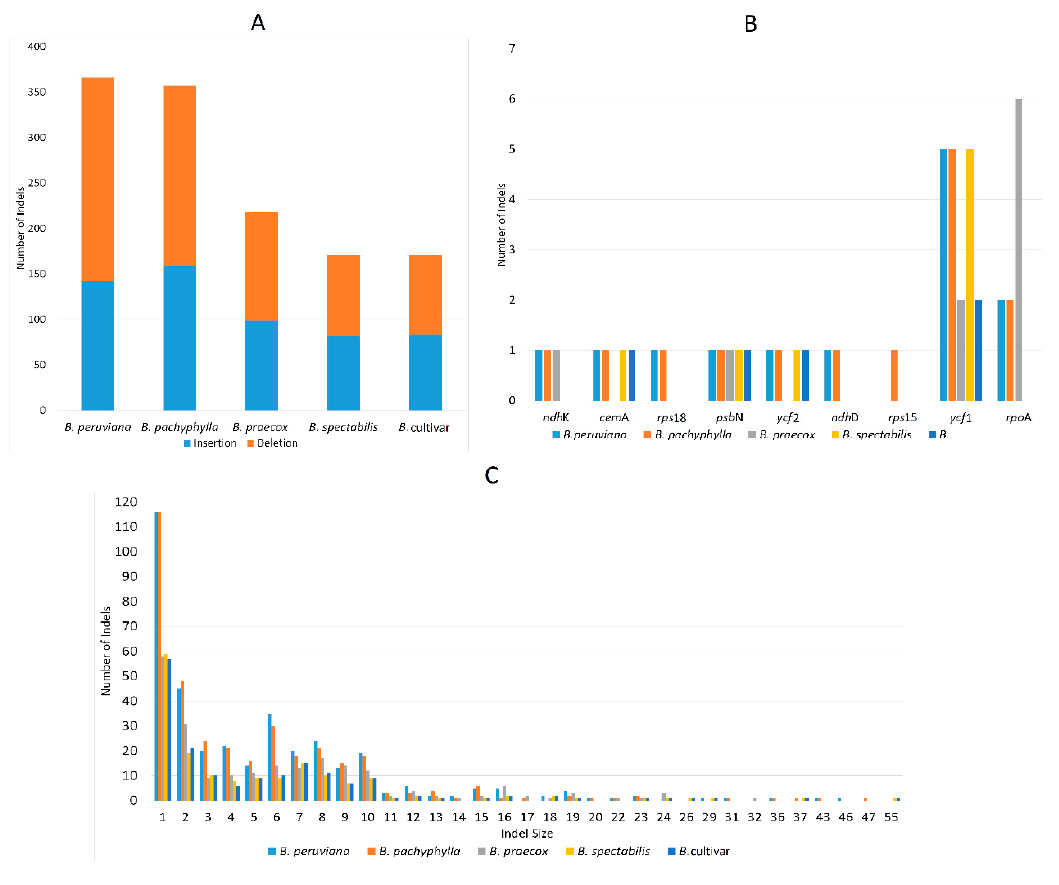
Figure 9. Summary of insertions and deletions found in five Bougainvillea cp genomes. ( A ) Total number of indels in five Bougainvillea species. ( B ) Numbers of indels located in the protein-coding genes. ( C ) Lengths of indels identified in five cp genomes.